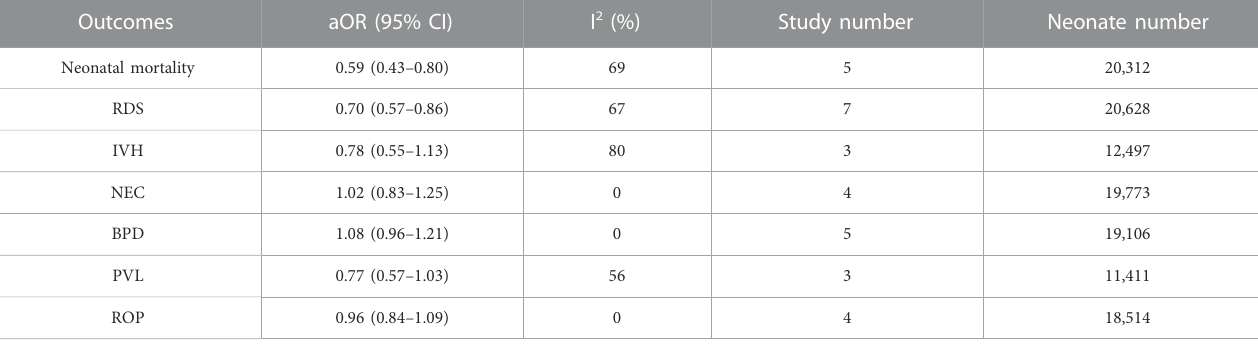
TABLE 1 Overall odds of outcomes among twin neonates who were exposed to antenatal corticosteroids (ACS) vs. those unexposed to ACS. Outcomes Study